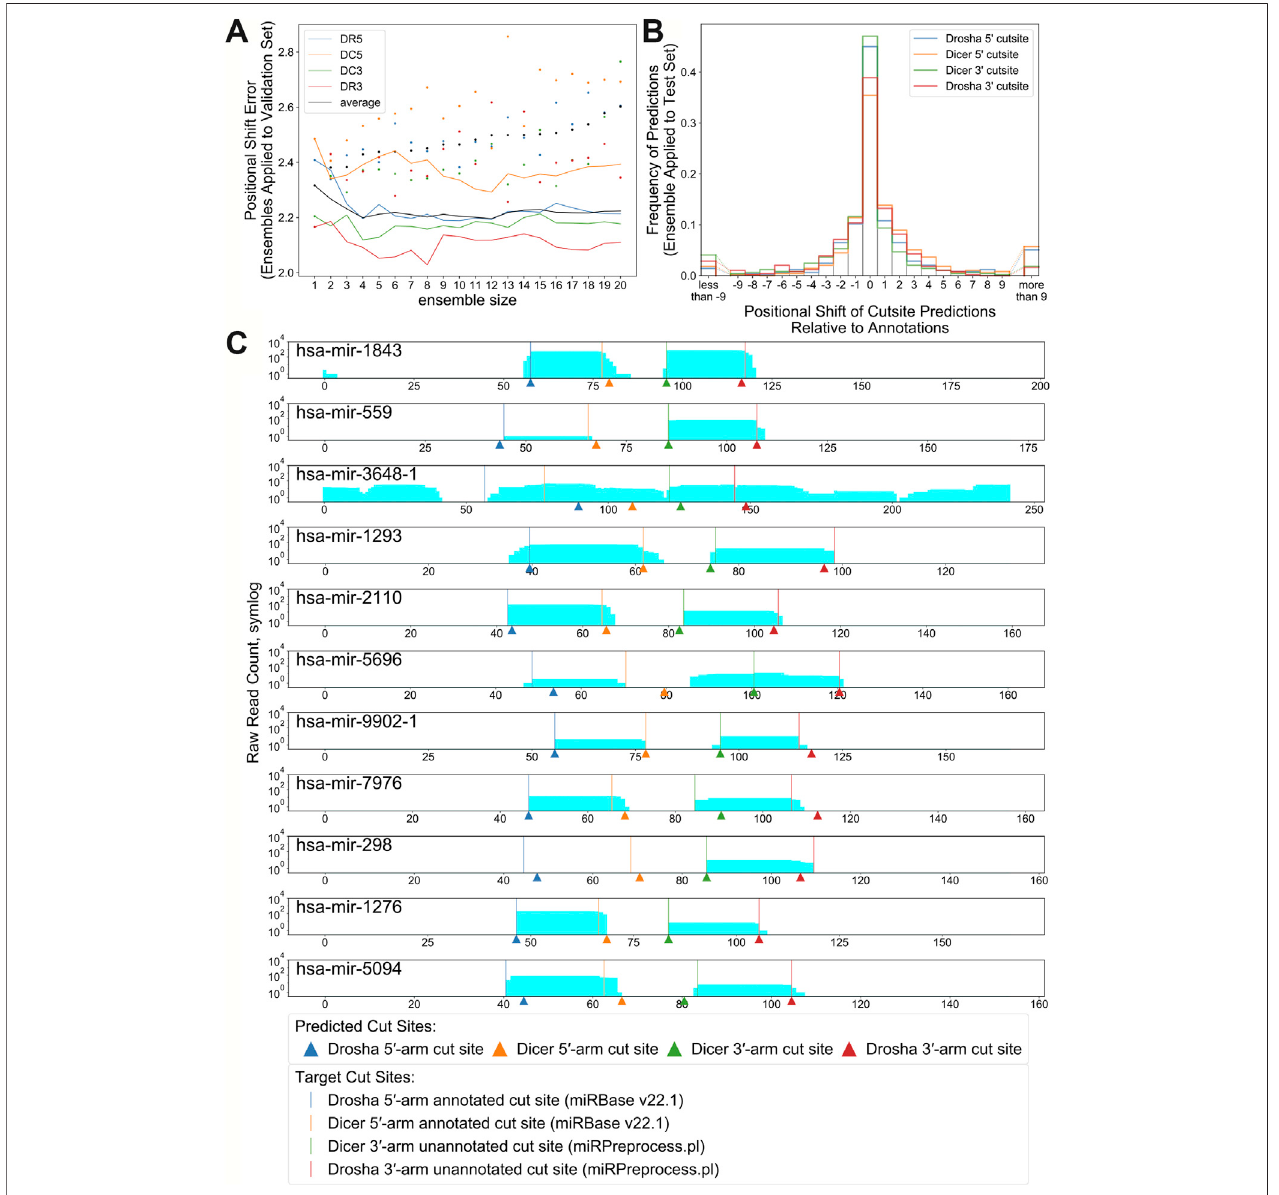
FIGURE 6 | (A) . Positional Shift Error found when ensemble bpRNA is applied to the validation set for ensembles of increasing size (dots represent PSE for individual replicates being added to the ensemble). (B) . Frequency of predictions relative to each cut site when ensemble bpRNA is applied to the test set with an ensemble size of 12. (C) . Mapped read counts and cut site predictions for known microRNA precursors with unannotated microRNAs on the 3 ′ arm. Vertical lines show thepositionofcutsitesthatareeitherannotatedinmiRBaseorpredicted usingthemiRPreprocess.plscriptfrommiRWoods.Arrows showthelocationofcutsites predicted by ensemble